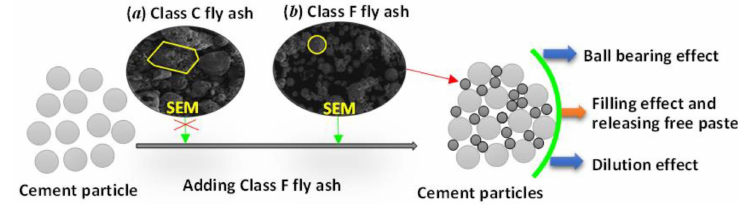
Figure 15. Effect of fly ash on the flowability of fresh wet